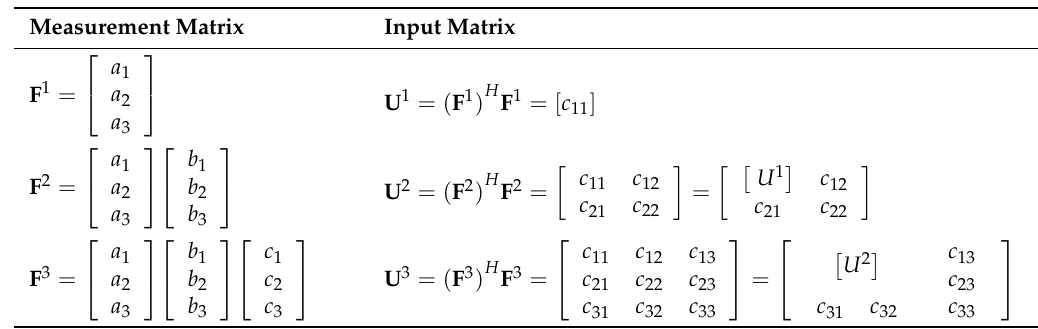
Table 1. Overlapped region in input